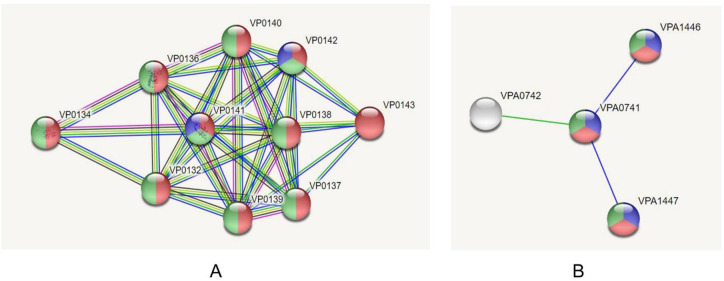
Investigation of PPIs through STRING v10.5 server; (A) UDP-N-acetylmuramoyl-L-alanyl-D-glutamate—2,6-diaminopimelate ligase (murE), (B) Trigger factor (tig).